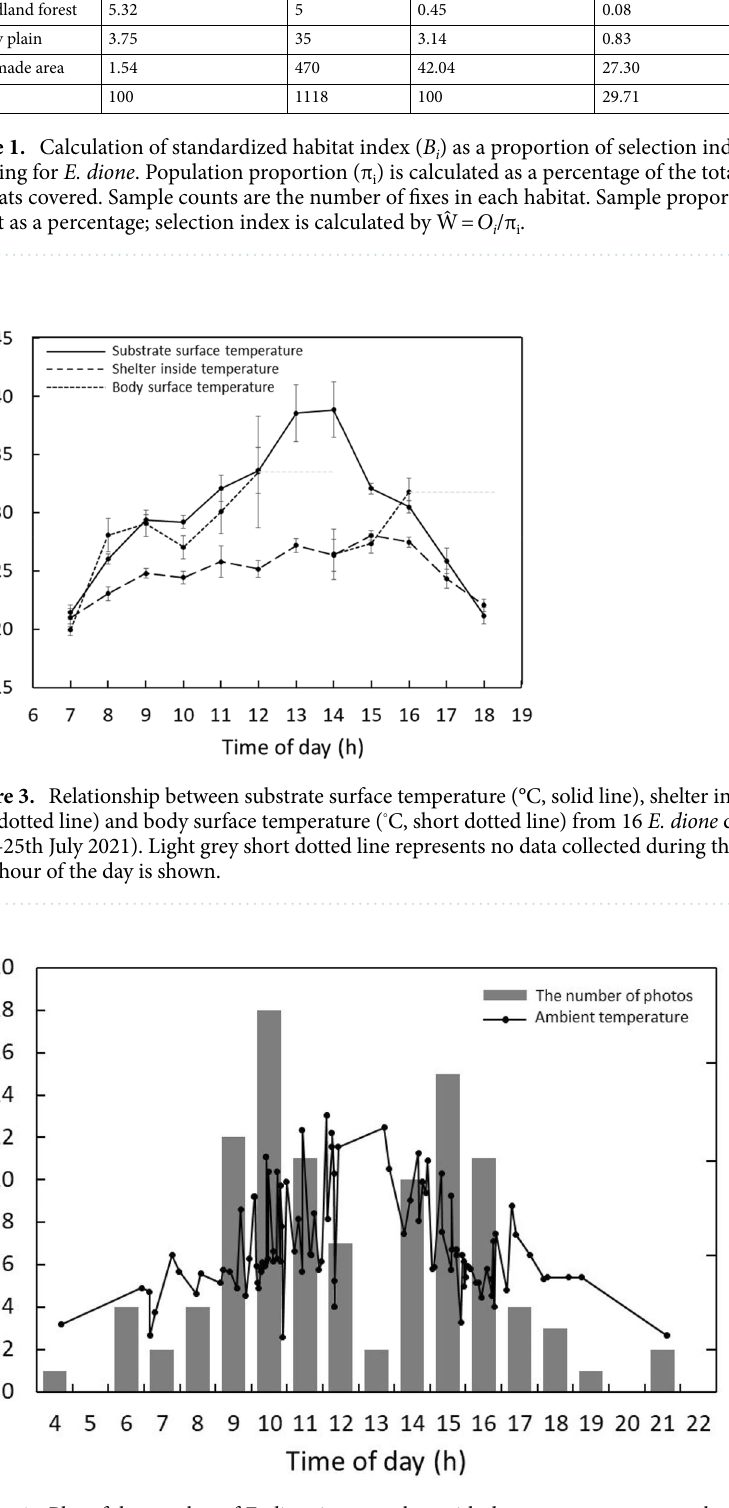
Figure 4. Plot of the number of E. dione images taken with the camera traps across the day. The number of images of E. dione taken by camera traps set at study area in relation to time of day and ambient temperature that images were